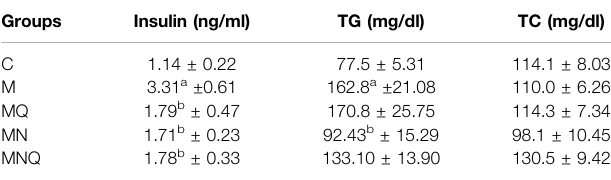
FIGURE 5 | fructose (10% in drinking water), high salt (3%) and high fat (25%) dietfor12 weeks.Resultsareexpressedasmean ± SEM(n (cid:2) 8forallgroups). * p < 0.05 when compared to the corresponding control (C) values, # p < 0.05 when compared to the corresponding MetS values using one-way ANOVA followed by Dunnet ’ s post-hoc